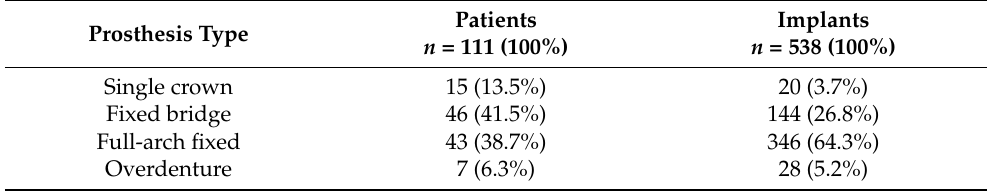
Table 3. Description of the prosthesis-type distribution between the total number of patients and implants used to support